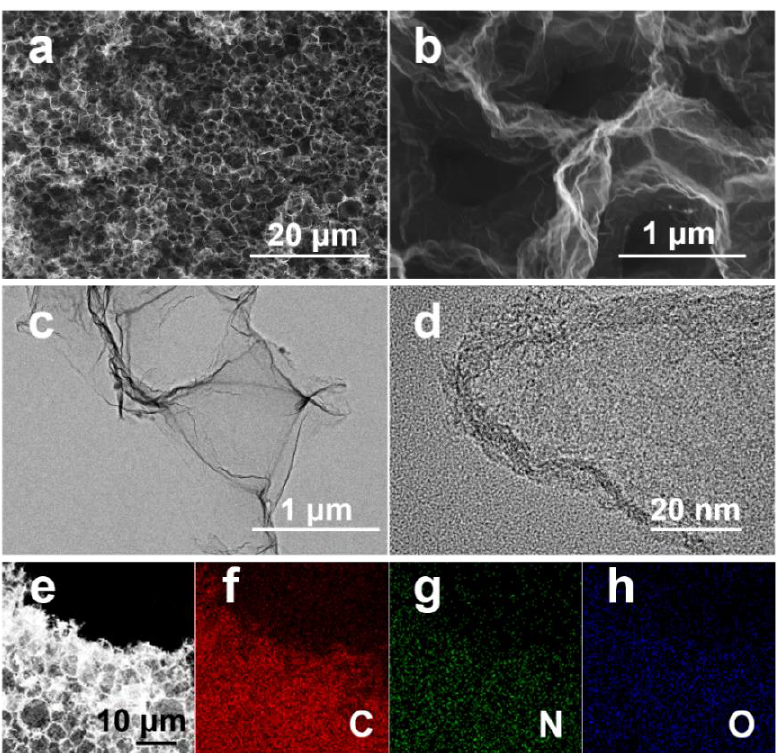
Figure 1. Morphology of ZnG. SEM images ( a , b , e ), TEM images ( c , d ), and elemental mapping of C ( f ), N ( g ), O ( h ).